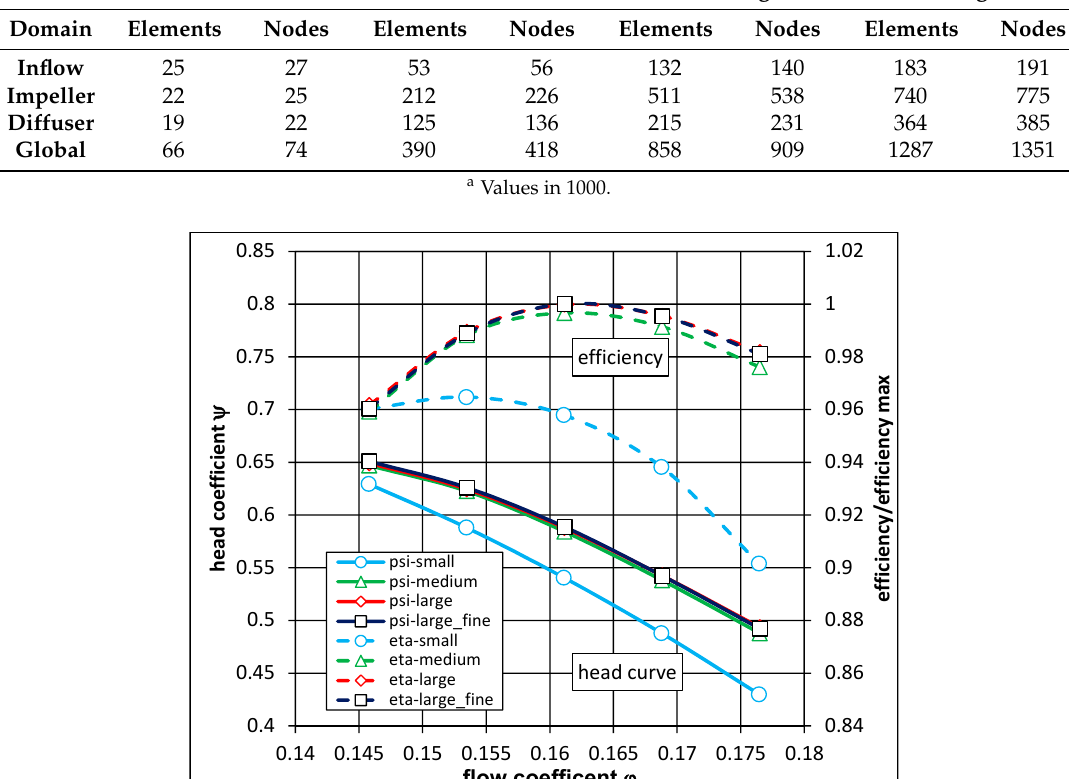
Table 3. General computational fluid dynamics (CFD)